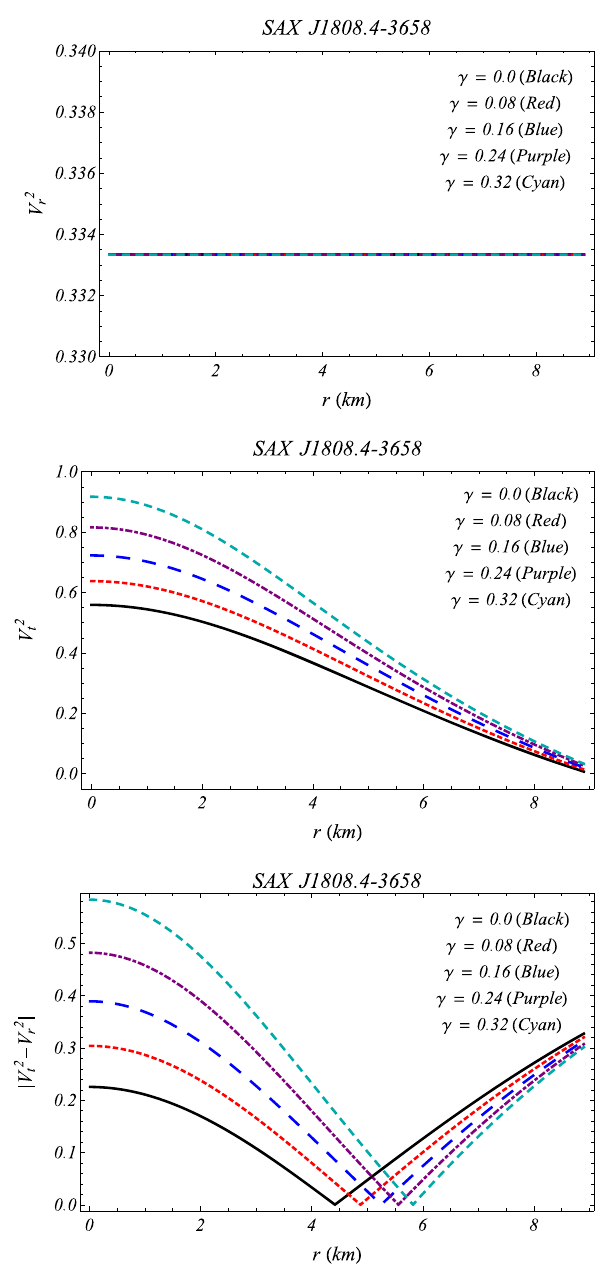
Fig. 3 (Top) Square of the radial sound velocity V 2 r , (middle) square of the transverse sound velocity V 2 t and (bottom) the stability factor | V 2 − V 2 | against r for the strange star candidate SAX r t